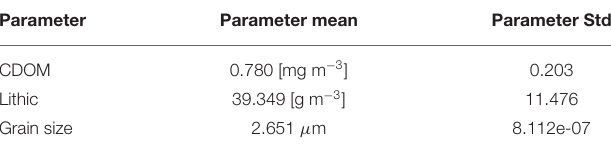
TABLE 8 | MCMC outputs for Imja